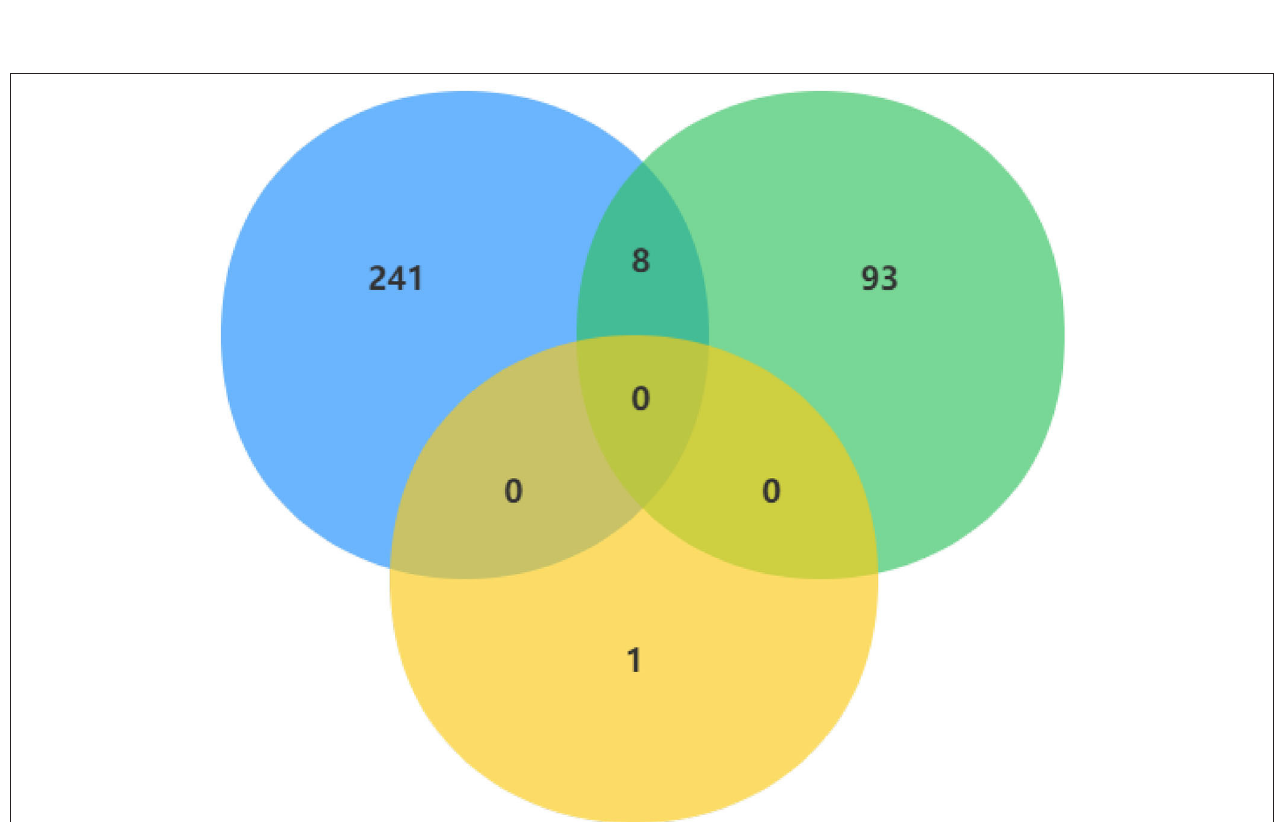
FIGURE 3 | DECs were obtained by overlapping GSE101586, GSE101684, and GSE112214 microarrays.